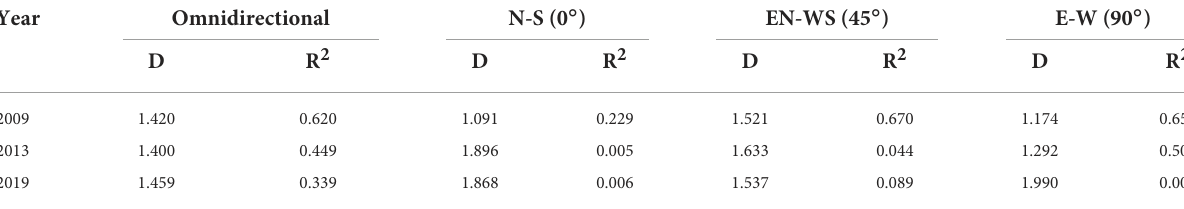
TABLE 3 The fractal dimension of the variation function of tourism eco-efficiency in Inner